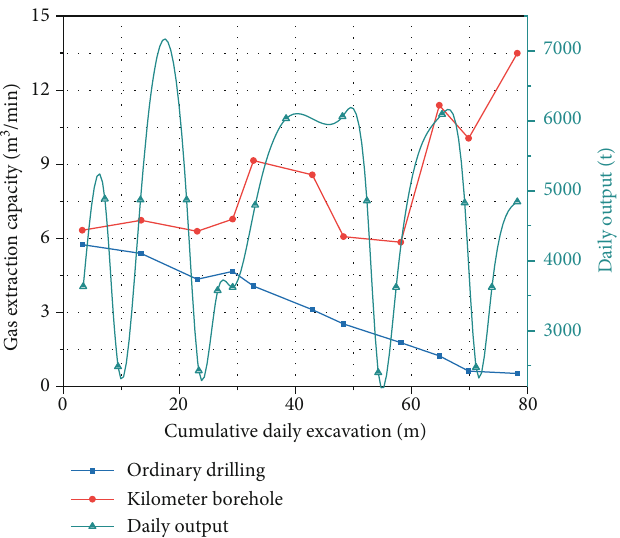
Figure 12: Gas drainage pure volume comparison of directional drillings and ordinary through layer